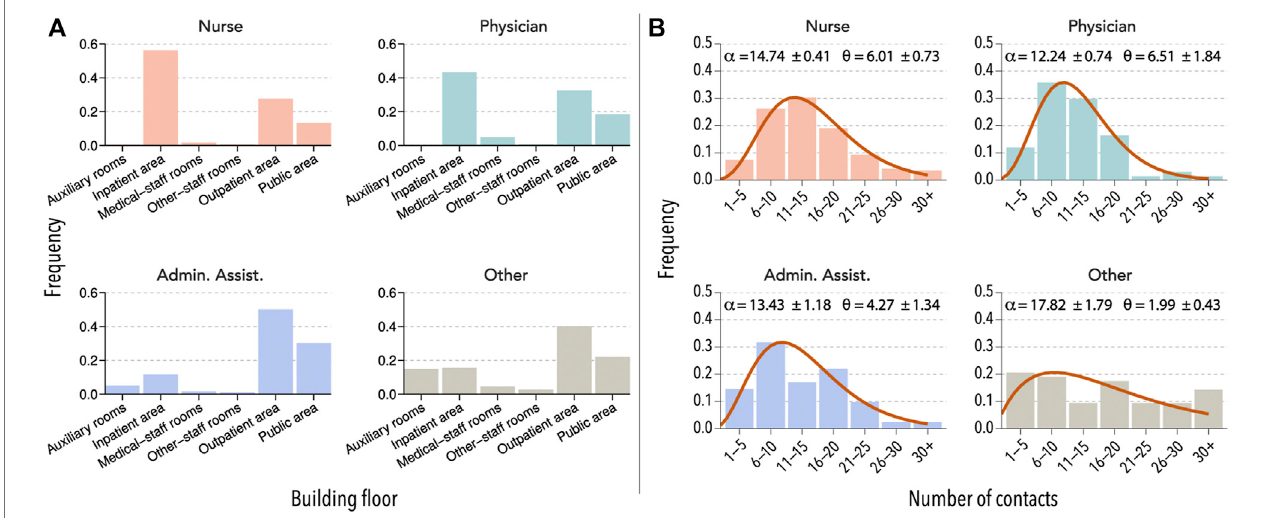
FIGURE1| Interaction patterns ofHCW. (A) Units visitedbyfour selected HCW groupsinhospital Bduring anormal week. (B) Thenumber ofdirect contacts with otherHCWsreportedbymembersofeachcategoryduringatypicalday.Thedistributionsare fi ttedtoaright-censorednegativebinomialdistribution,with α representing the mean and θ the dispersion parameter.